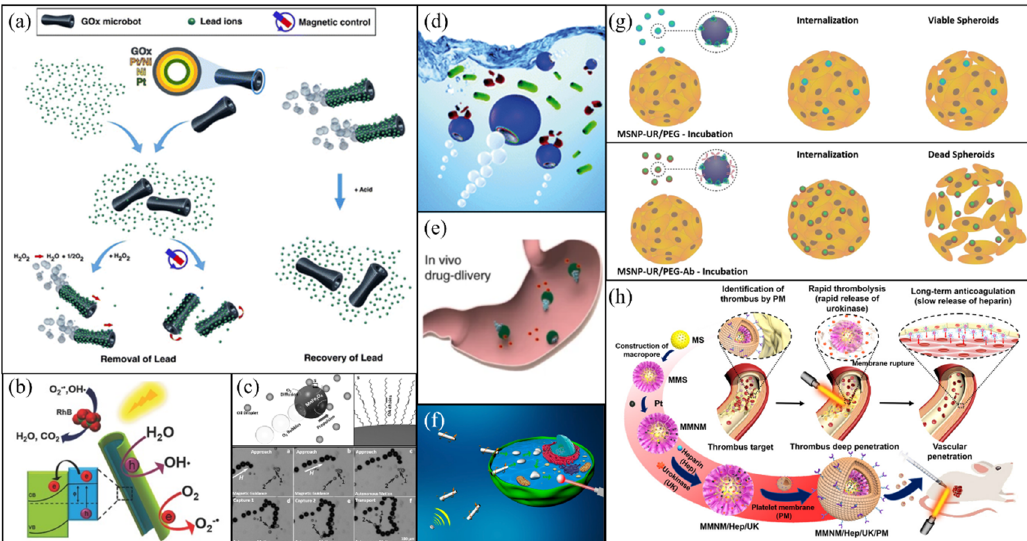
Figure 4. Applications of MNMs in water remediation and biomedical microrobots. ( a ) Functionalized microtubes remove Pb 2+ in water and then are recycled with magnets. Reprinted with permission from [142]. ( b ) Scheme showing photocatalytic degradation of organic molecules using light-driven microtubes. Reprinted with permission from [143]. ( c ) MnFe 2 O 4 micromotors can remove oil pollutants directly from contaminated water by physical adsorption. Reprinted with permission from [145]. ( d ) A schematic drawing of chitosan coated Janus spheres in cleaning bacteria contaminated water. Reprinted with permission from [146]. ( e ) An illustration displaying antibiotic modified Janus sphere to cure stomach infections. Reprinted with permission from [150]. ( f ) An illustration showing fusible acoustic driven Ga nanowires to kill a HeLa cell. Reprinted with permission from [152]. ( g ) Comparison between micromotors with and without antibody in the internalization efficiency for 3D spheroids of bladder cancer cells. Reprinted with permission from [154]. ( h ) Schematic illustration of the components of platelet-derived porous nanomotor and their functions in thrombolytic treatment. Reprinted with permission from [79].